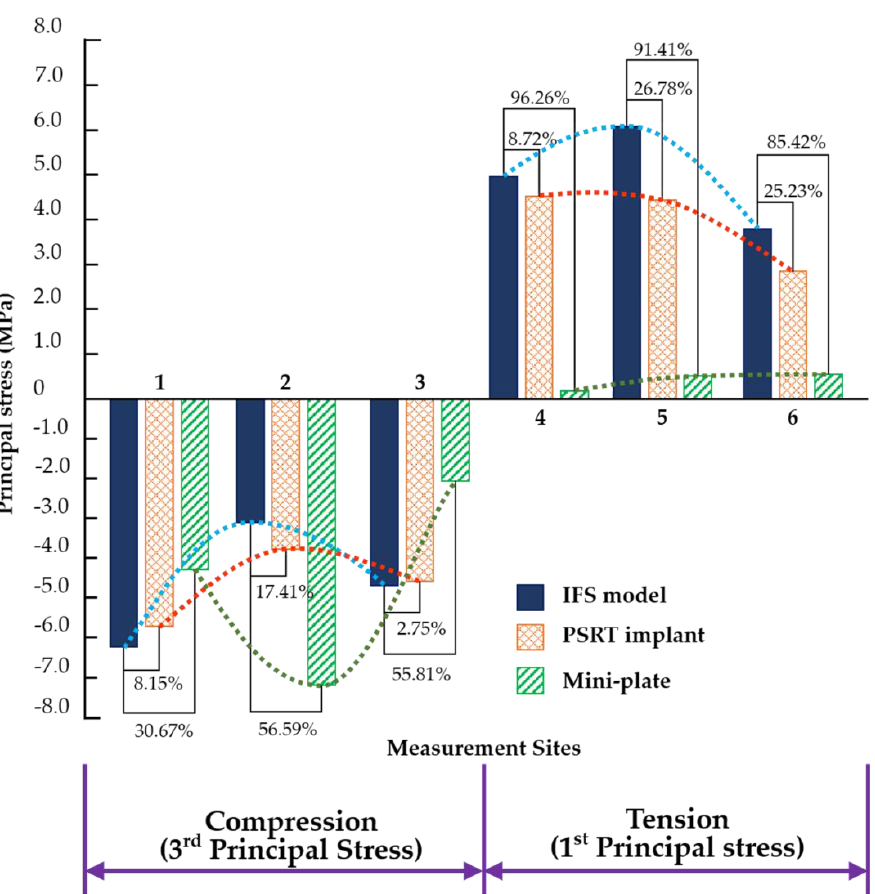
Figure 7. Comparison of the maximum/minimum bone stress value among the IFS model, the ZMC fracture repair with thin implant and traditional mini-plates. A similar stress pattern between the IFS model and repair with the PSRT implant, i.e., convex curves were found while connecting the maximum stress value from points 1 to 3 and points 4 to 6. However, a different corresponding curve trend was found for repairs with mini-plates from points 1 to 3.